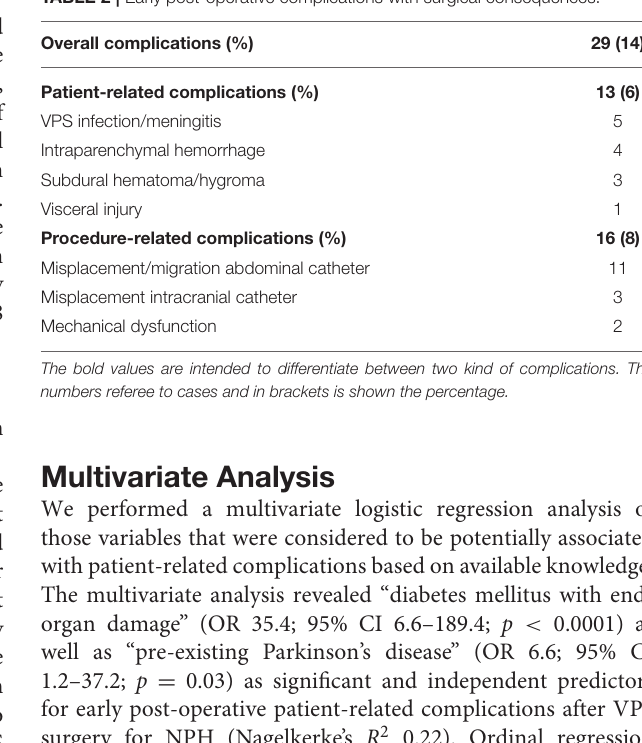
TABLE 2 | Early post-operative complications with surgical